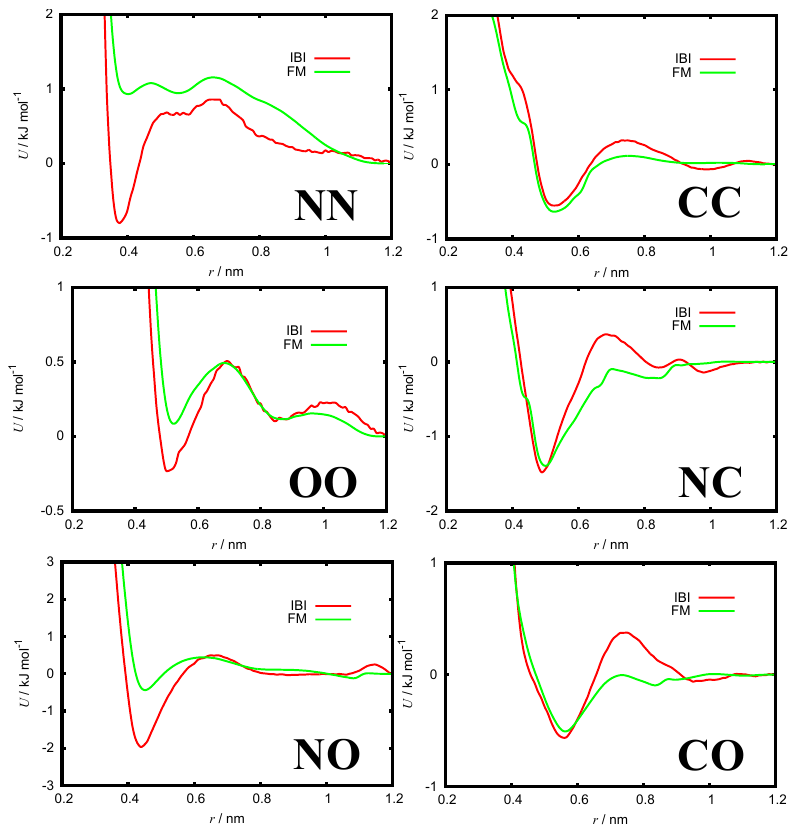
Figure 2. Coarse − grained nonbonded potentials obtained from IBI and FM for CB7CB at 370